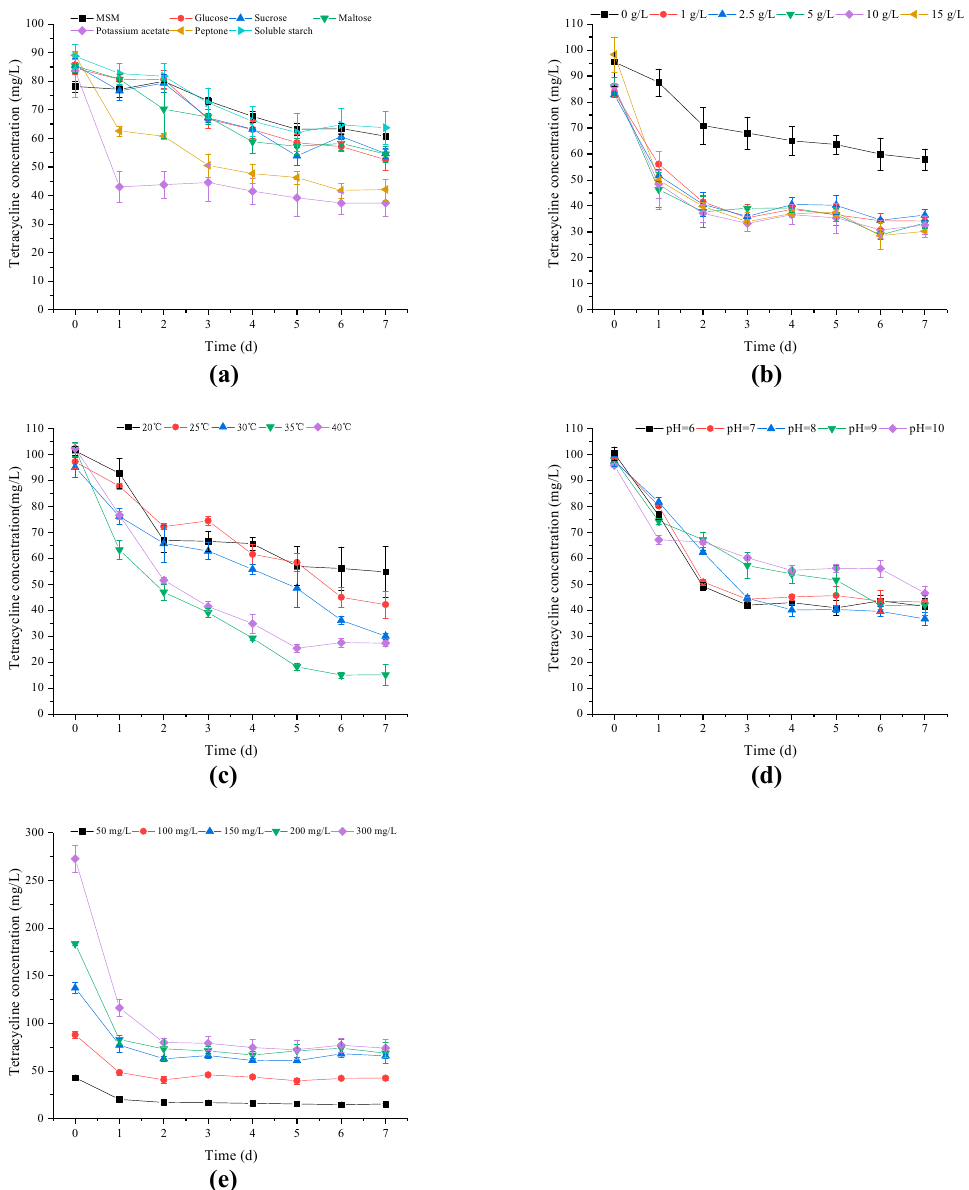
Figure 2. Effects of different carbon sources ( a ), potassium acetate concentrations ( b ), temperature ( c ), pH values ( d ), and initial tetracycline concentrations ( e ) on TC degradation by strain M503. Values are expressed as mean of three replicates with standard deviations.